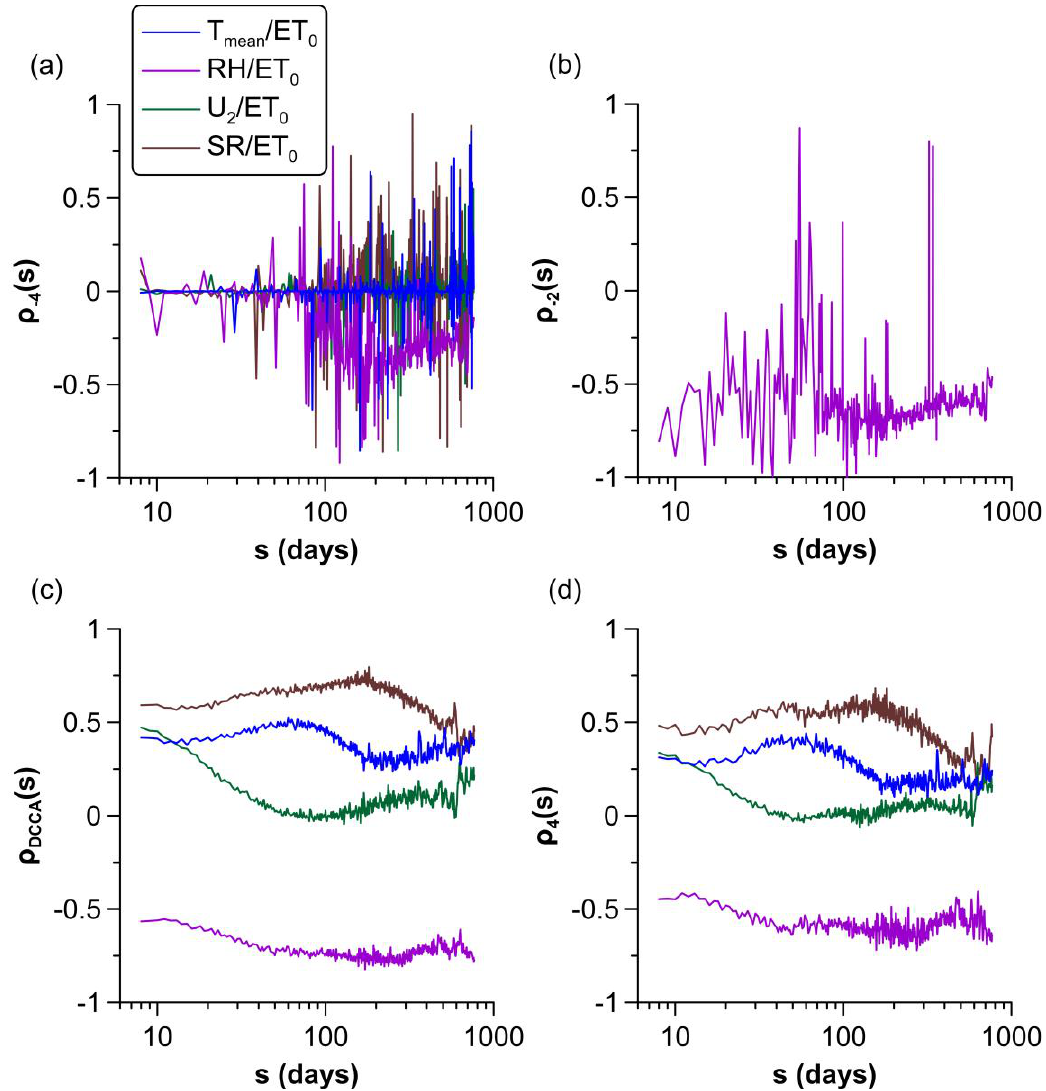
Figure 8. q -dependent detrended cross-correlation coefficients 𝜌 𝑞 (𝑠) vs. the scale, 𝑠 , for different values of 𝑞 . ( a ) 𝑞 = −4 . ( b ) 𝑞 = −2 . Curves of the 𝑇 𝑚𝑒𝑎𝑛 —𝐸𝑇 0 , 𝑈 2 — 𝐸𝑇 0 and 𝑆𝑅—𝐸𝑇 0 links are omitted because of the presence of violent fluctuations in the range [−1,1] . ( c ) 𝑞 = 2 ( 𝜌 𝐷𝐶𝐶𝐴 (𝑠) ). ( d ) 𝑞 = 4 .